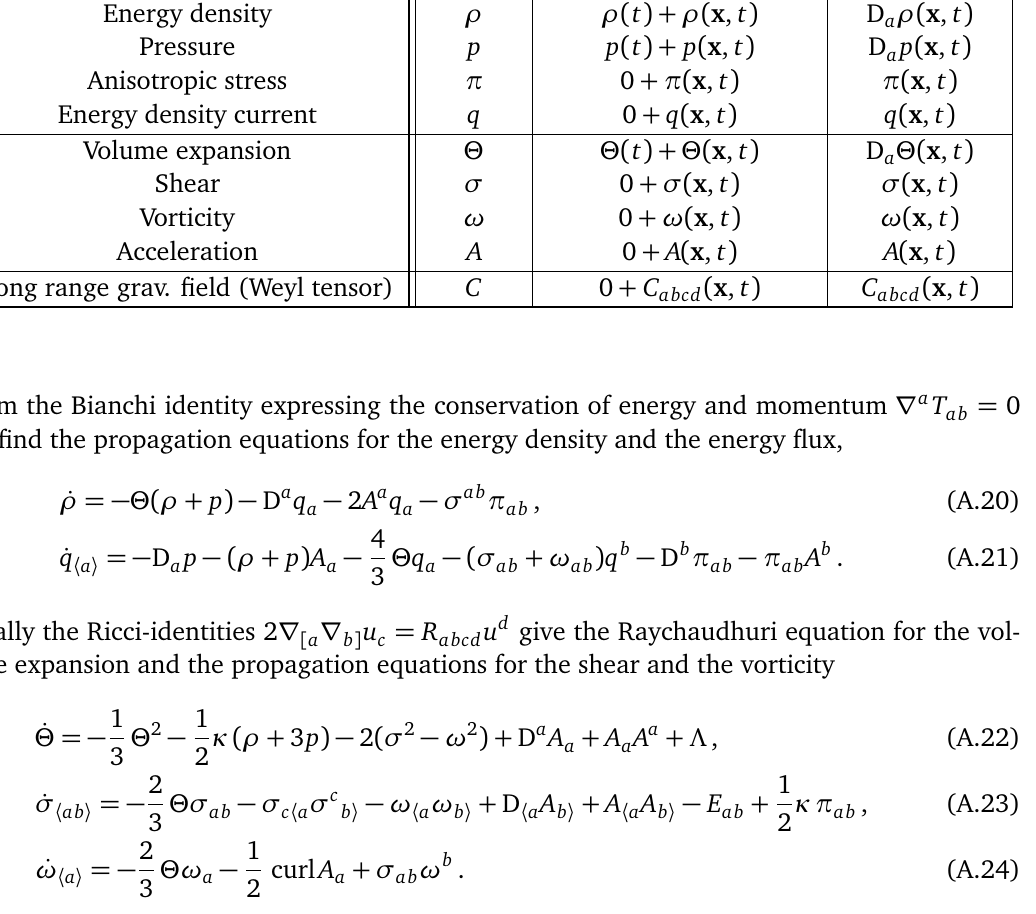
Table 1: Perturbative expansion of the central quantities in the 1 + 3 covariant theory in a FLRW background and their first order gauge invariant version. In the third column the first term refers to the zeroth-order component and the second term to δ S ≡ ε S ( 1 ) . Since for most quantities the zeroth-order part is zero and hence S = δ S we often neither use the superposed index nor the δ -symbol for their first-order term. Perturbative Expansion Variable Symbol First order GI S = S ( 0 ) + ε S ( 1 ) Energy density Anisotropic